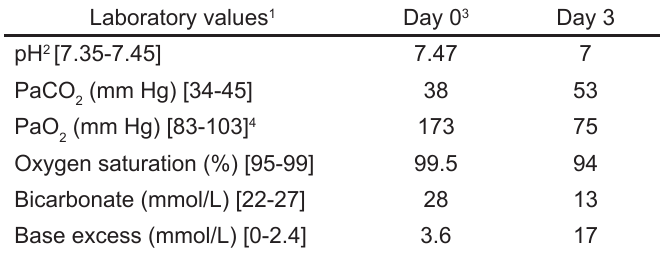
Table 2. Patient’s arterial blood gas on day of admission and